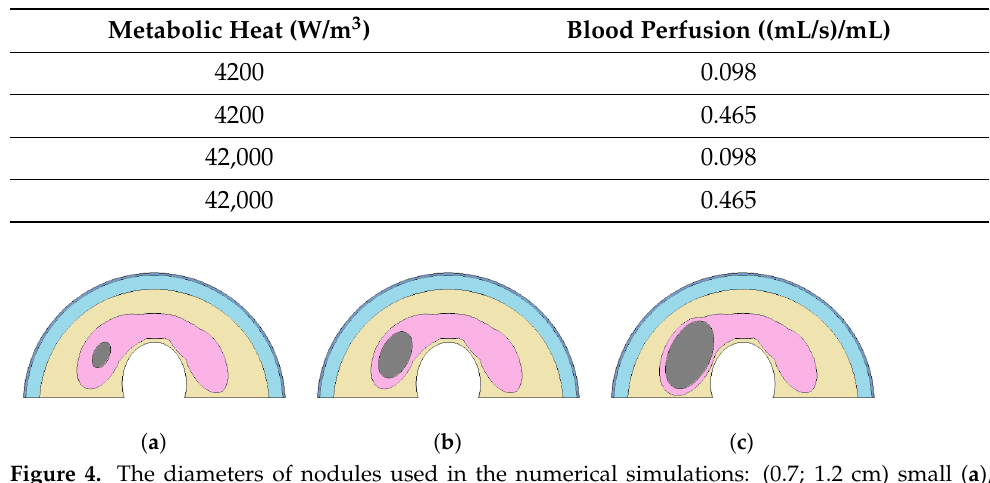
Table 2. Combinations of metabolic heat and blood perfusion for the thyroid nodule used in the simulations. These values are from [26,28,51].